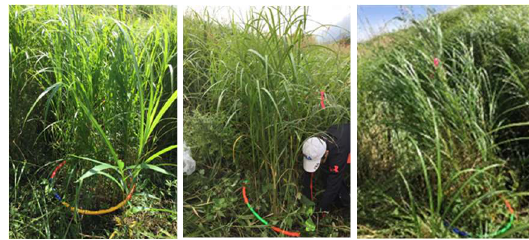
Figure 4. A circular plot of 62.5 cm diameter for vegetation survey on top of the hill (left), slope (center) and sunken place